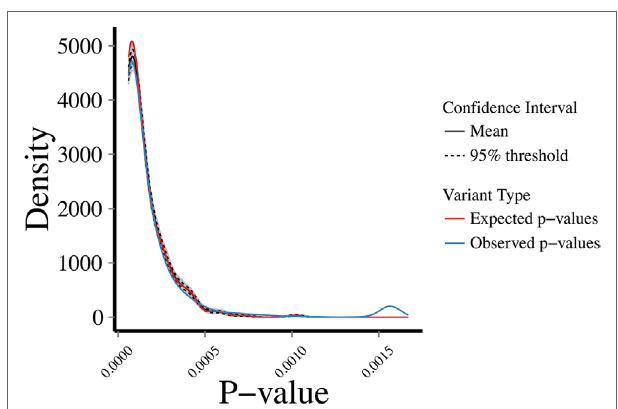
FIGURe 3 | Bootstrapping simulations between a set of (1) expected: p -values between 13,005 genes not reported to cause disease and their predicted CDGs; (2) observed: p -values between new human gene mutation database genes (i.e., not used to generate the CDGs presented in this study) and their predicted CDGs. Test performed by random sampling using a Gaussian